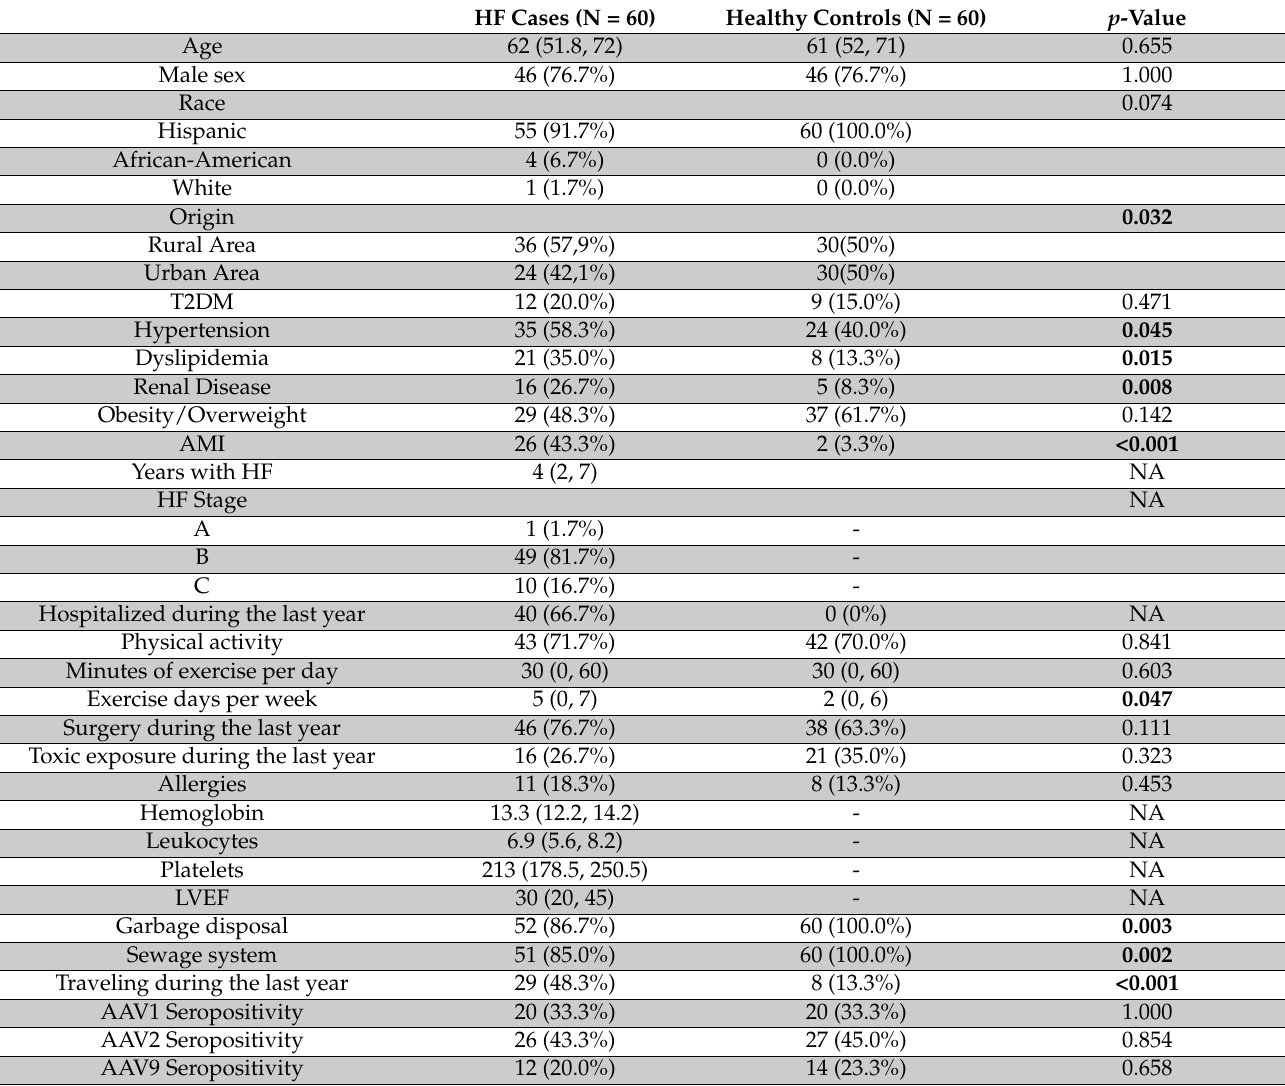
Table 1. Main sociodemographic characteristics of the sample.